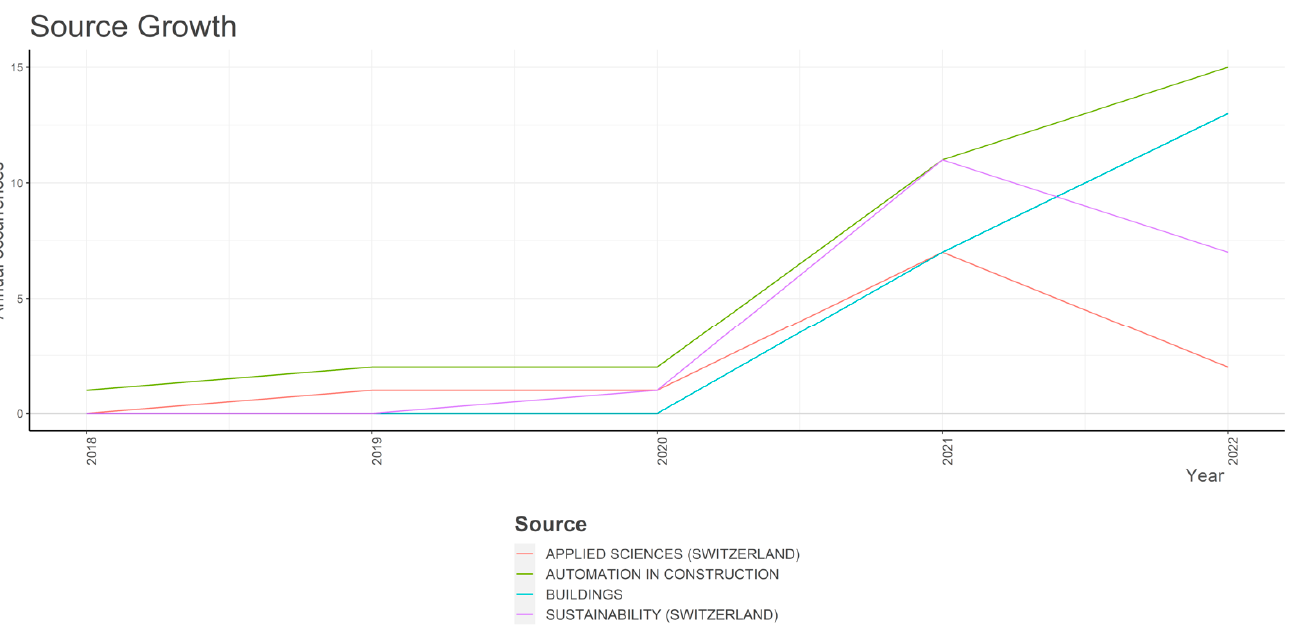
Figure 9. Sources’ articles publication by year analysis, performed with Biblioshiny version 4.0.